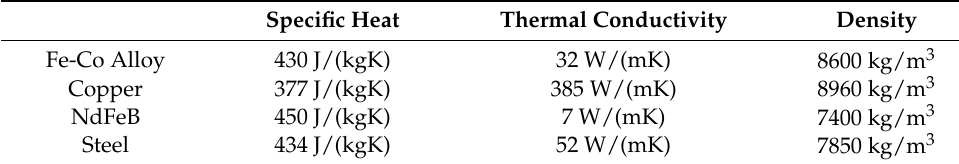
Table 6. Thermal properties of the chosen materials.